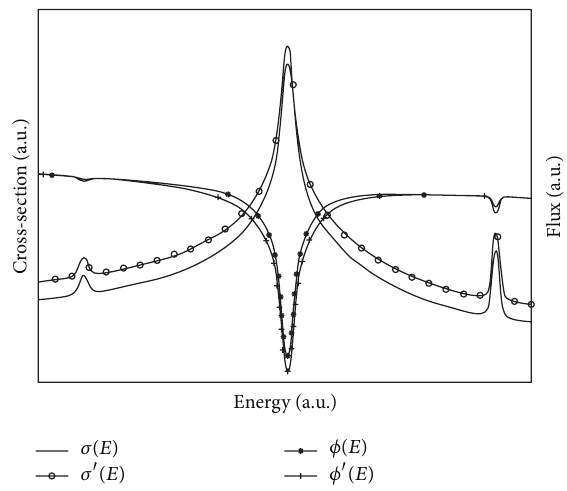
Figure 1: Cross-section, 𝜎(𝐸) , and flux, 𝜙(𝐸) , with their perturbed (marked with prime)